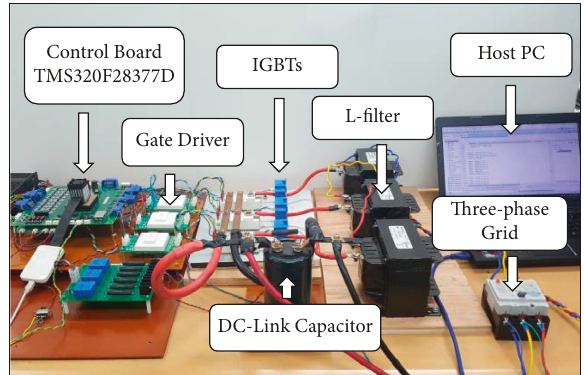
Figure 13: Experimental setups.